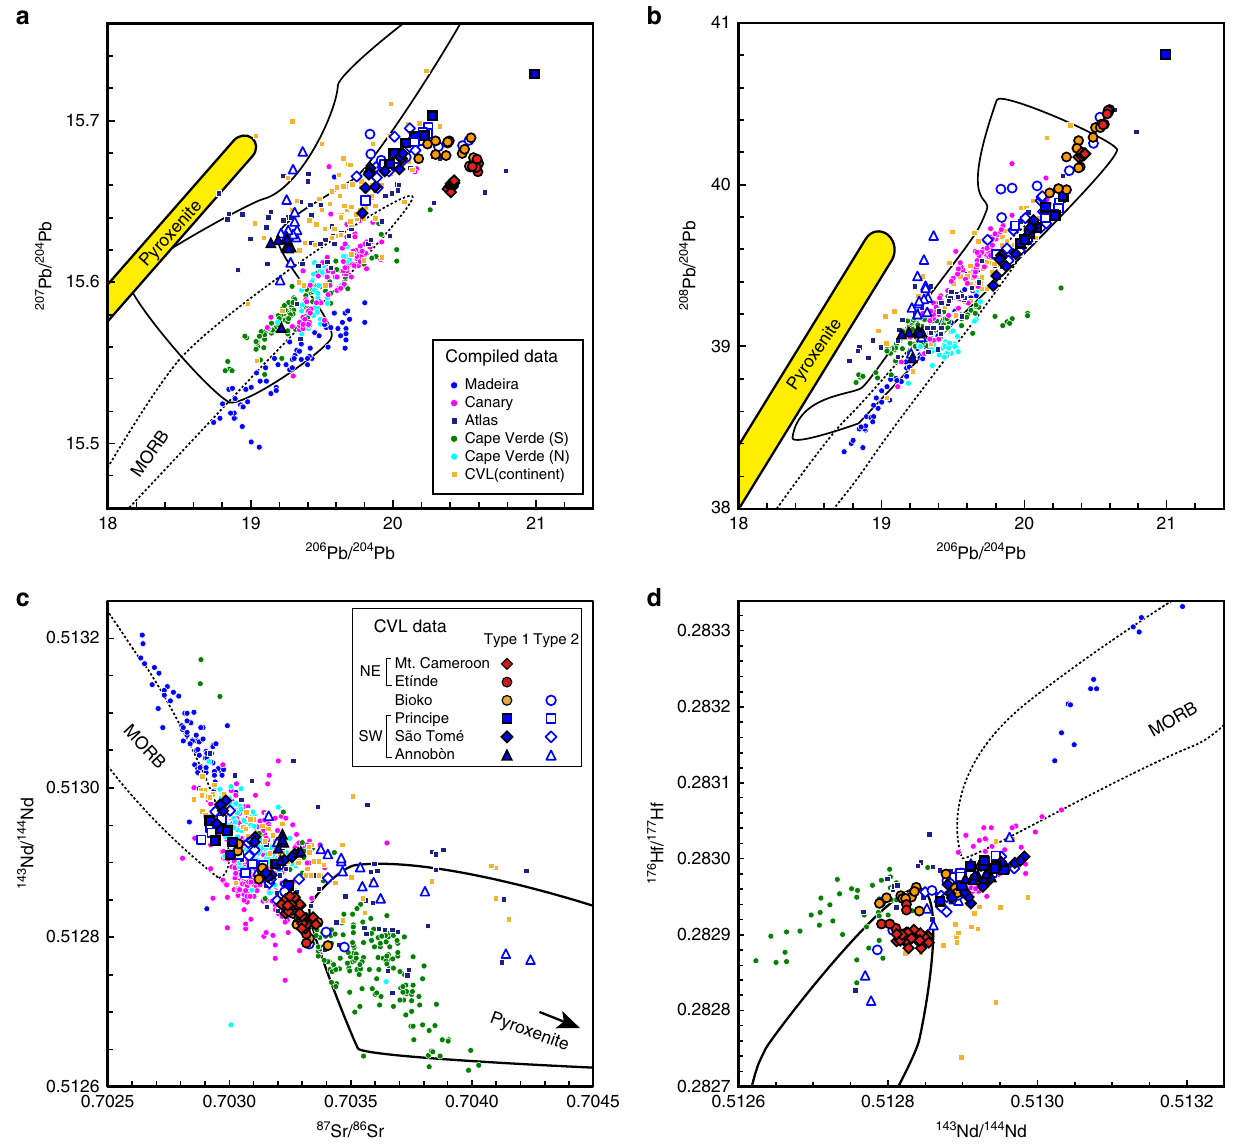
Fig. 6 Sr – Nd – Hf – Pb isotopic compositions of Cameroon volcanic line (CVL) basalts plotted with other West African passive margin intraplate basalts. a 206 Pb/ 204 Pb vs. 207 Pb/ 204 Pb; b 206 Pb/ 204 Pb vs. 208 Pb/ 204 Pb; c 87 Sr/ 86 Sr vs. 143 Nd/ 144 Nd; and d 143 Nd/ 144 Nd vs. 176 Hf/ 177 Hf. The data for Mt. Cameroon are from ref. 20 . The range for mid-ocean ridge basalt (MORB) shown with broken curves was compiled with high-precision Atlantic MORB data collected between 30°N and 30°S; these data were analysed either by the double spike or Tl-addition methods and were compiled from the PetDB database (www.earthchem.org/petdb). The data for the Madeira Islands, the Canary Islands, the Atlas Mountains, the southern and northern Cape Verde islands, and the continental CVL were compiled by the GEOROC database. All the Pb isotopic data for the Canary Islands, Cape Verde, and the continental sector of the CVL were analysed either by the double spike or Tl-addition methods. Because no Pb isotopic data analysed by either the double spike or Tl- addition methods were available for the Madeira and Atlas samples, the Pb data analysed by conventional methods were compiled for samples from these regions. The solid curve is the calculated Kimberlite-source mantle composition. The 2 SD error bars are smaller than the symbols for CVL data. The source data of the compiled values are provided in ref.